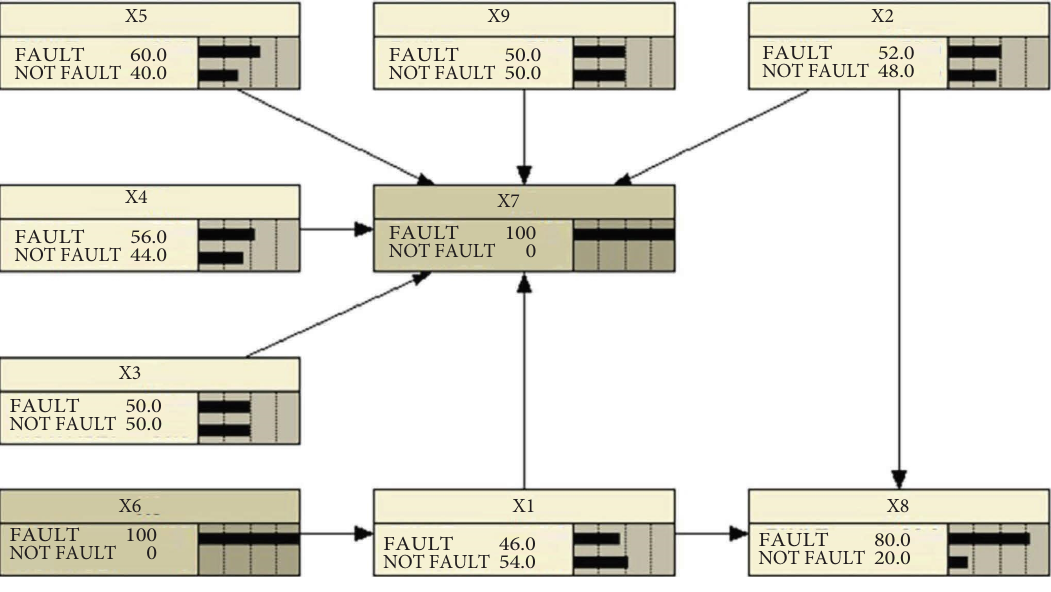
Figure 16: Bayesian network of CSTR process fault. Table 3: Other variables fault detection